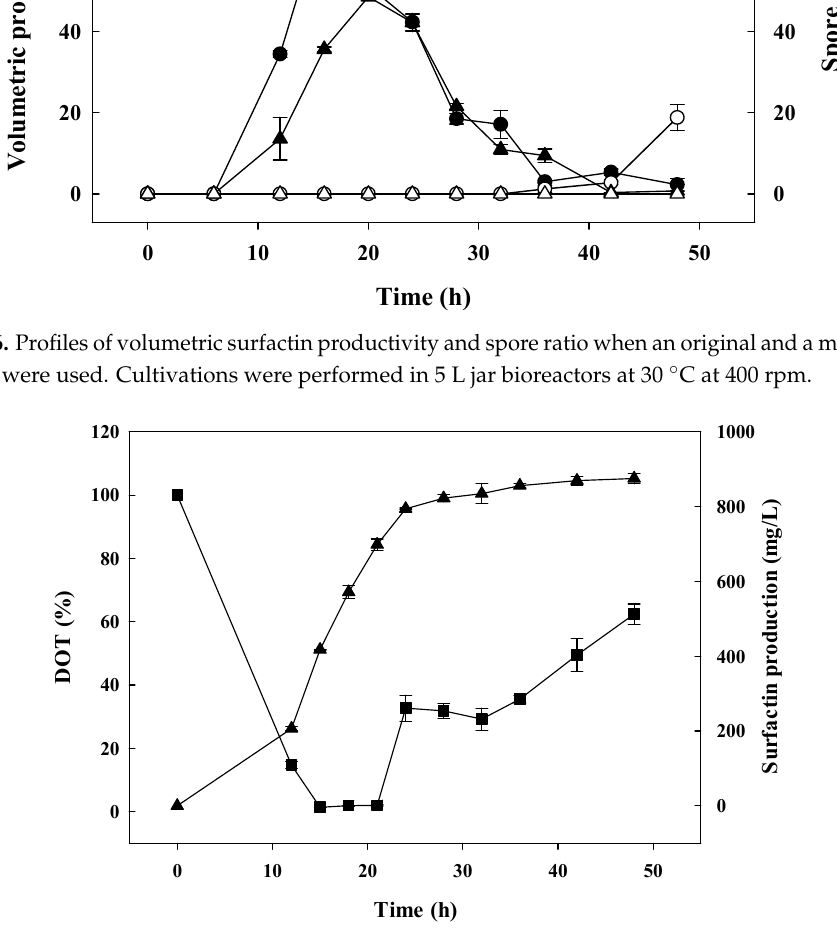
Figure 7. Surfactin production when a mesh-type sparger was used. Cultivations were performed in 5 L jar fermenters at 30 °C for 48 h.